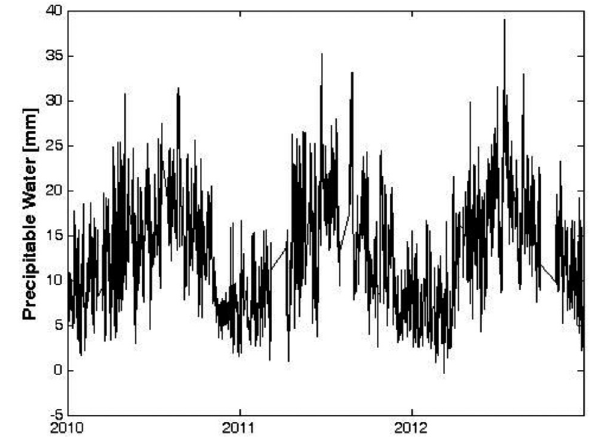
Figure 6. Time series of PW based on the GPS ZWD and Π calcu- lated using linear model of Iran during 3